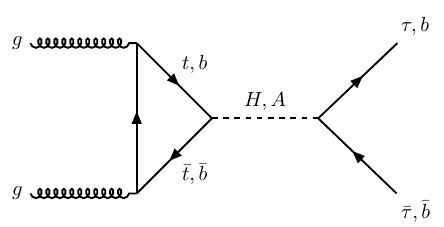
Figure 3 . Feynman diagram for the production of the new scalars H and A via gluon fusion.